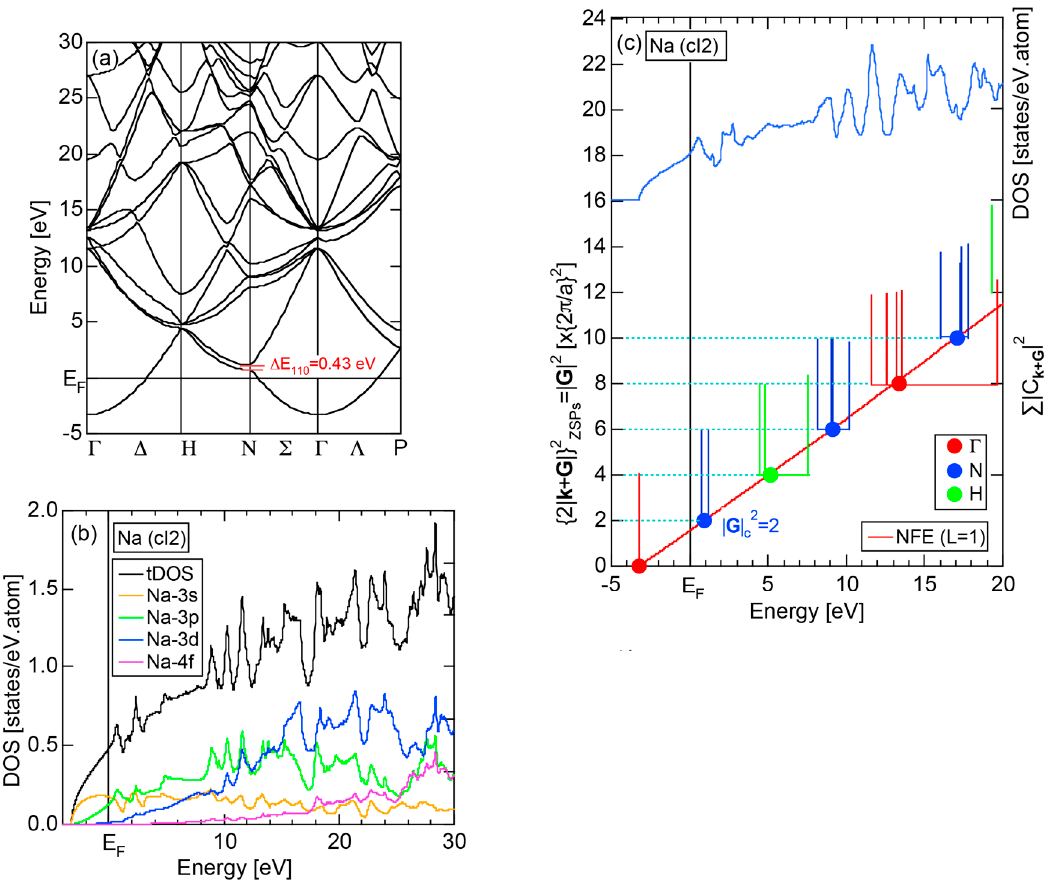
Figure 9. ( a ) Dispersion relations; ( b ) total- and partial-DOSs and ( c ) Full potential Linearized Augmented Plane Wave ( FLAPW ) -Fourier spectra at symmetry points Γ , N and H of the bcc Brillouin zone for Na (cI2) [11]. An energy gap across {110} zone planes is marked with red color in ( a ). Its total-DOS is incorporated in ( c